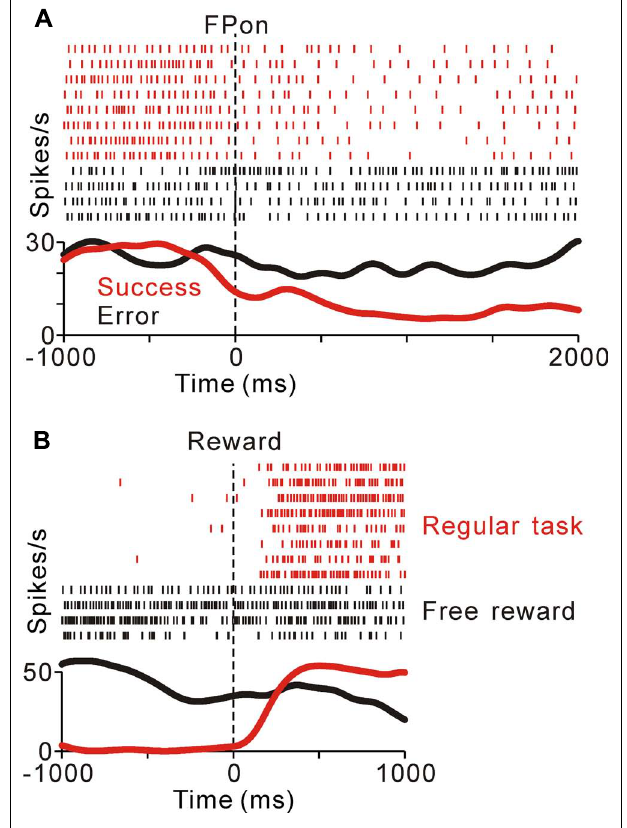
FIGURE 3 | (A) Response of a representative tonic suppressive neuron in successful (red) and erroneous (black) trials. In the successful trials, this neuron showed a decrease in tonic activity around the time of FP appearance; however, there was no decrease in activity in the erroneous trials. (B) The rastergrams and spike density functions for a representative tonic suppressive neuron aligned to the delivery of free (black) and task (red) rewards.This neuron exhibited a rebound of activity shortly after reward delivery in the task condition, but remained totally unresponsive to an unexpectedly delivered